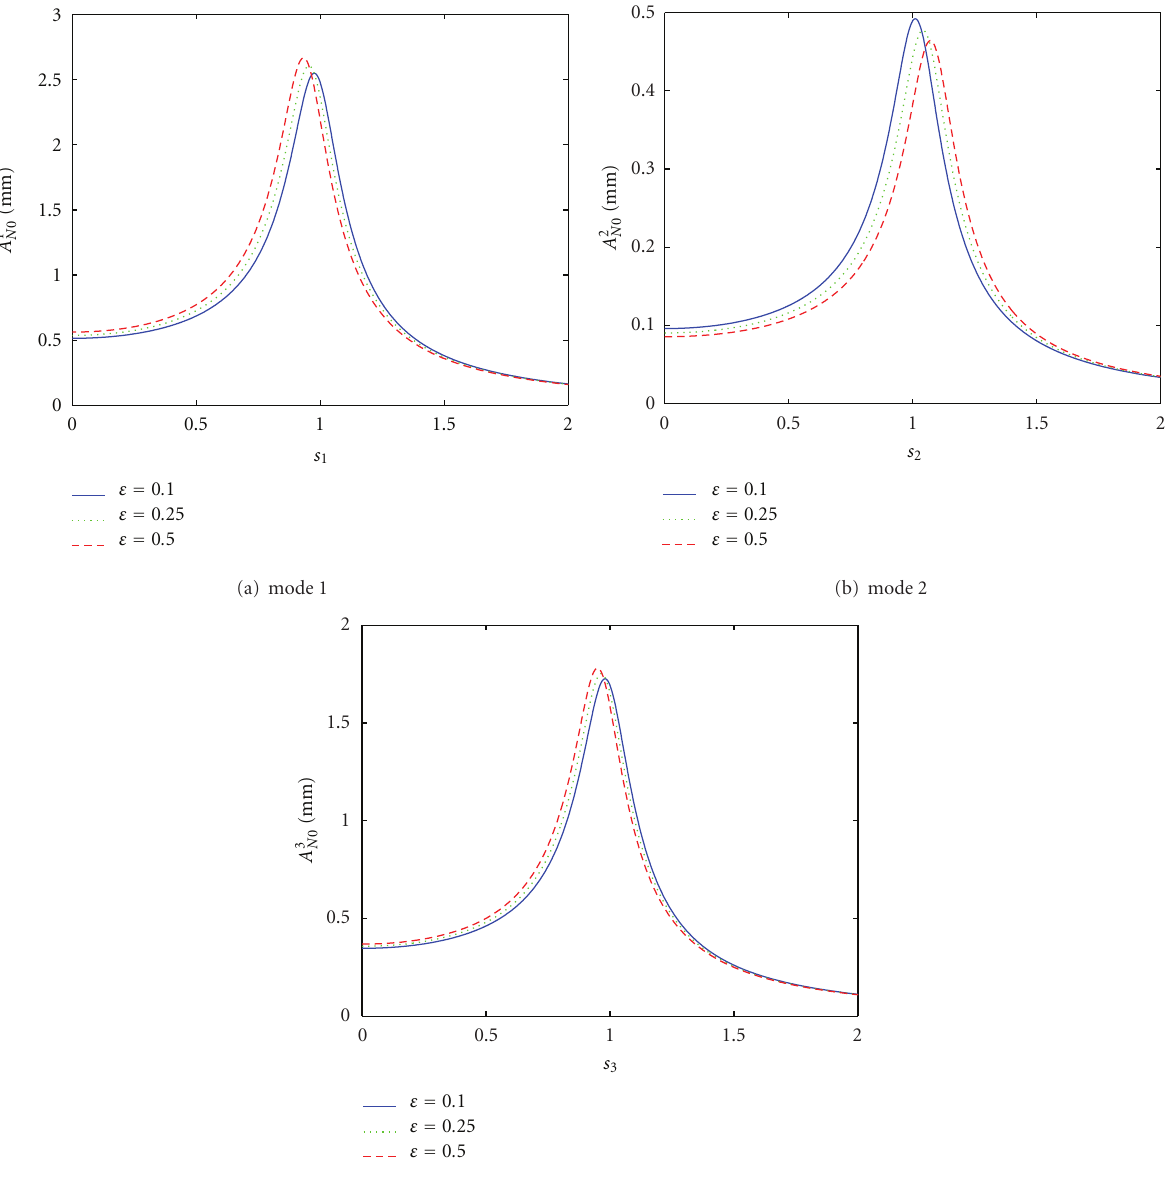
electric excitations should not be taken as integral multiple of the mesh parameter exciting